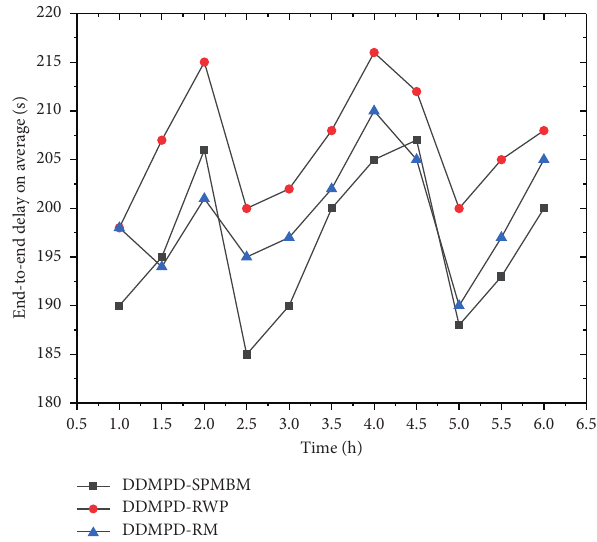
Figure 16: Relationship between average delay and time in three mobile